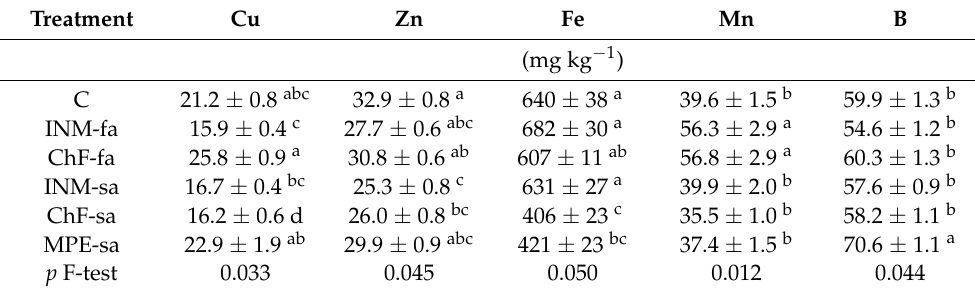
Table 2. Effect of fertilization through different (root/foliar) application methods on leaf essential micronutrients content of Origanum microphyllum . C: control (water); INM: integrated nutrient management (INM) by foliar application (INM-fa) or soil application (INM-sa); ChF: conventional fertilization by foliar application (ChF-fa) or soil application (ChF-sa); MPE-sa: mixture of plant extracts as biostimulant by soil application. Nutrient content was expressed per dry weight basis. Values represent the mean of three replicates ±